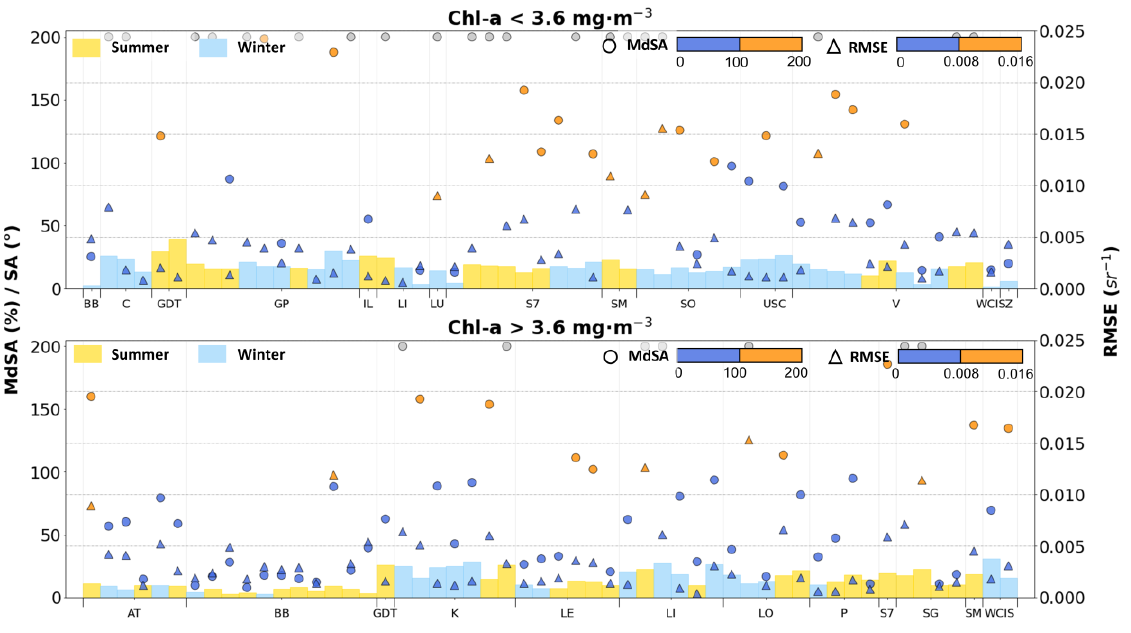
Figure 6. Statistical analysis to assess the accuracy of the data through representation of three different metrics: MdSA (%) and SA (°) on the principal axis, RMSE (sr − 1 ) on the secondary axis. The SA is represented by the bars in the graph. The grey dots refer to cases where the MdSA value is over 200%. In the x-axis are reported the 20 different sites (using the acronyms shown in Figure 1).